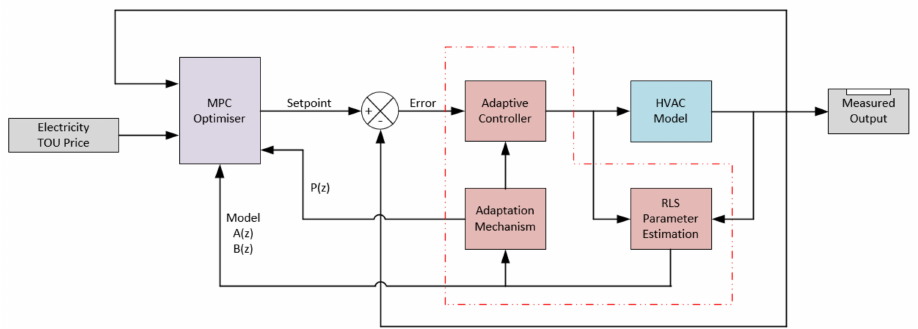
Figure 1. Supervisory model predictive control (MPC) plan showing a detailed breakdown of the inner loop adaptive controller. The MPC optimiser continued iterating until a setpoint trajectory that produced the least cost was found. These generated setpoints were then sent to the localised adaptive controller, which in turn sent control signals to the heating, ventilating, and air-conditioning (HVAC)